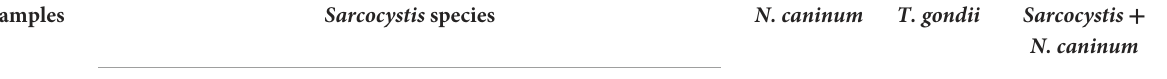
TABLE 3 Prevalence of Sarcocystis , N. caninum and T. gondii infection among sheep. No.